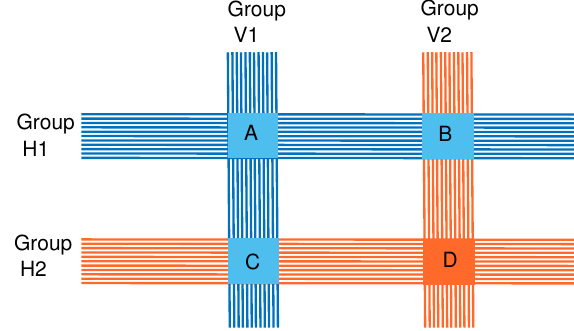
Figure 8. A brief scheme of profile